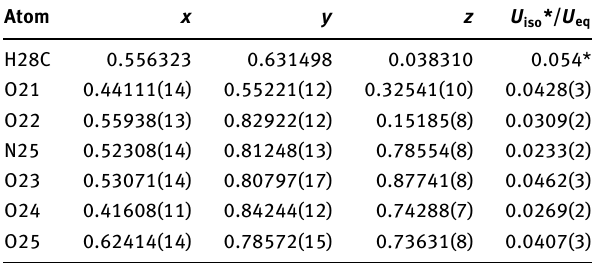
Table 2: Fractional atomic coordinates and isotropic or equivalent isotropic displacement parameters (Å 2